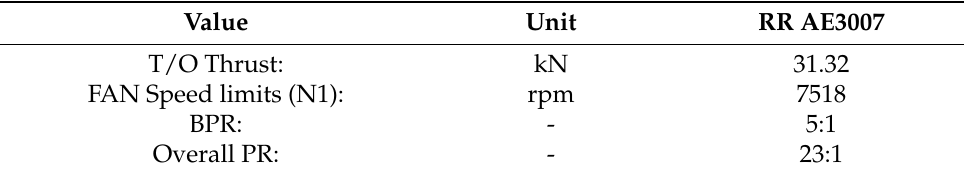
Table 2. Basic Engine Design Parameters